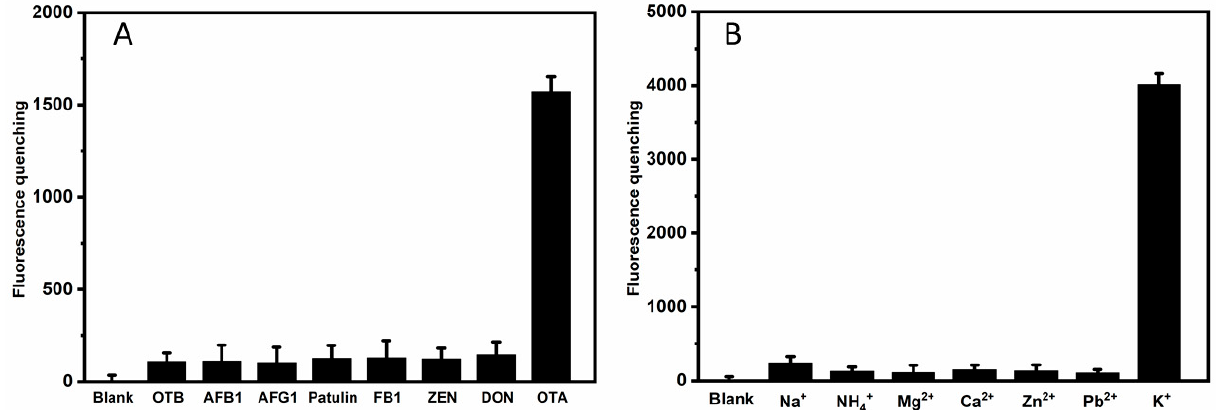
Figure 4. ( A ) Selectivity performance of sensing system for OTA detection with the addition of OTB, AFB1, AFG1, Patulin, FB1, ZEN, and DON to the solution. The concentration of ions is 62.5 nM. ( B ) Selectivity performance of sensing system for K + detection with the addition of NH 4+ , Na + , Ca 2+ , Mg 2+ , Zn 2+ , and Cd 2+ ions to the solution. The concentration of toxins is 62.5 µM. The fluorescence-quenching is the difference between response and blank. The error bar represents the standard deviations of the three parallel experiments.